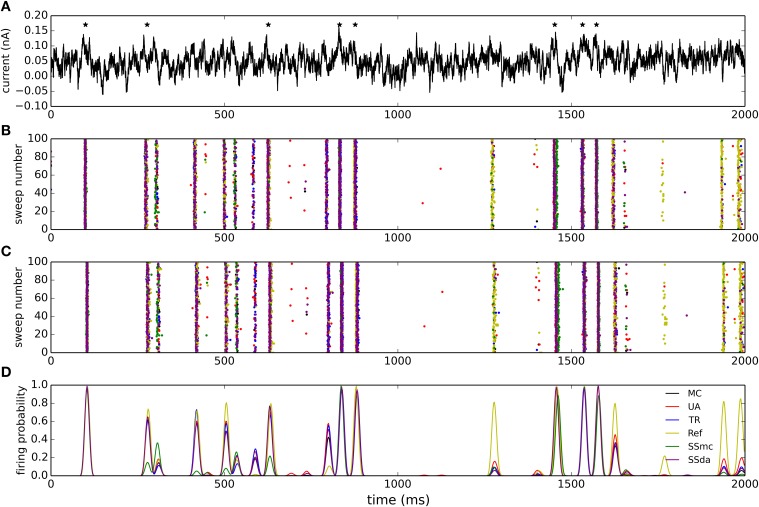
Stimulation of the multi-compartmental model with a noisy current injection. (A) Noisy current employed to stimulate the model. The trace was obtained as an Örnstein-Uhlenbeck process with τ = 5 ms. The mean of the depicted trace is 0.05 nA and the standard deviation is 0.03 nA. Stars denote the times at which action potentials are elicited in a deterministic simulation.(B) Raster plots of action potentials detected at the soma during 100 of the simulations performed with each algorithm (from a total of 400). The color of the dots represents the algorithms according to the legend in (D). (C) Raster plots of action potentials detected at the tip of the axon. (D) Smoothed normalized firing probability obtained from the 400 simulations. The rasters were discretized in bins of 2 ms, adding 0.0025 for each action potential detected in a bin. The resulting vectors were then smoothed by convolving with a Blackmann filter function of length 20.